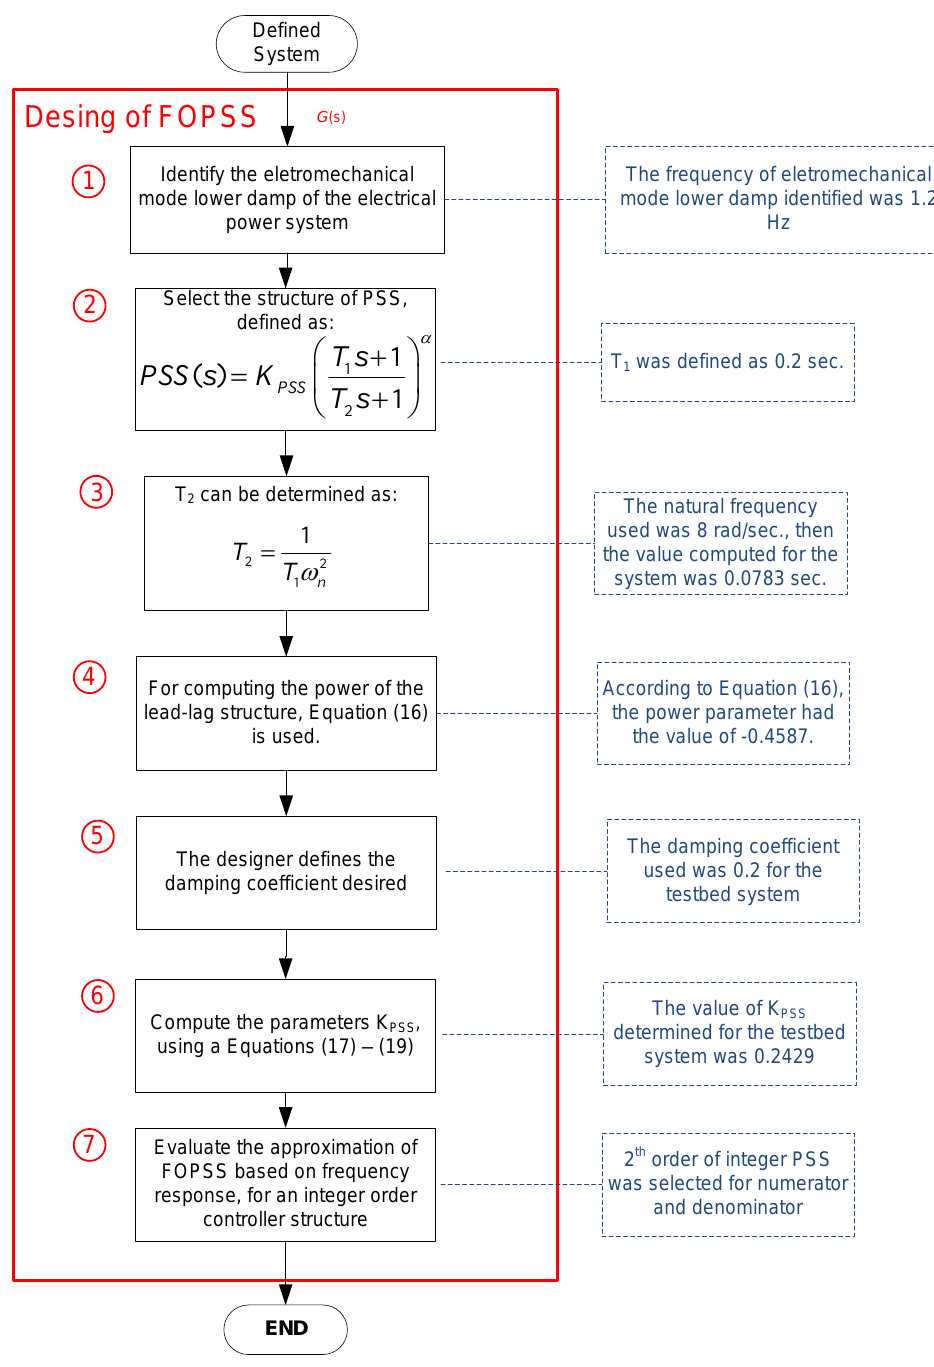
Figure 9. Flowchart describing the FOPSS design methodology.